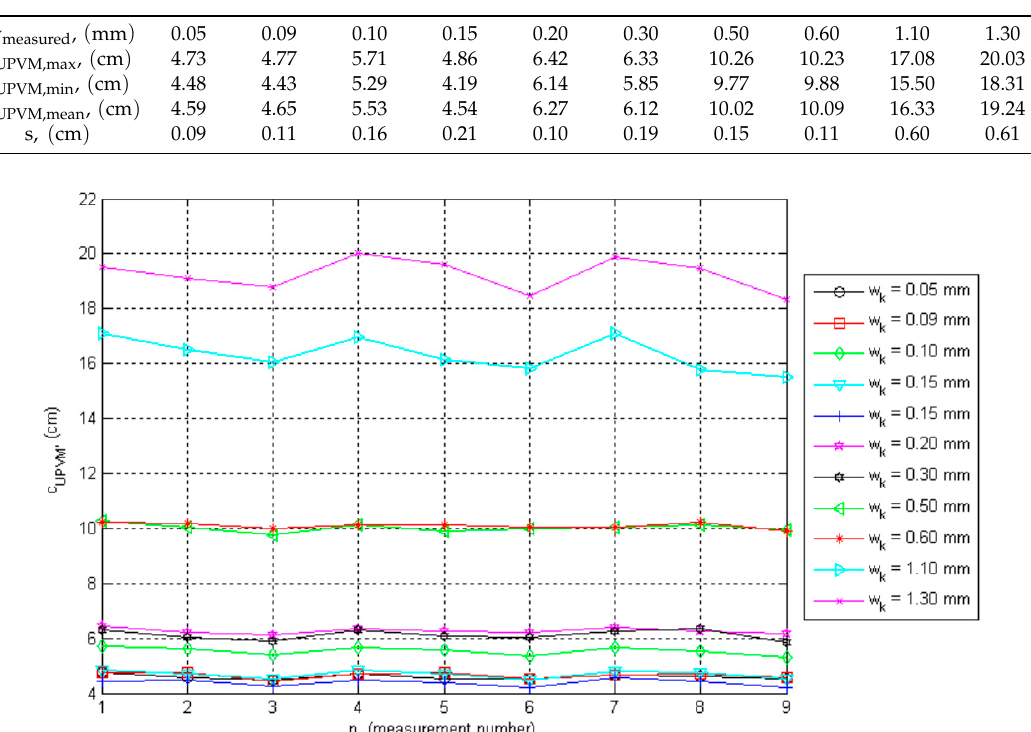
Table 2. Maximum, minimum and mean value of depths of cracks determined by non-destructive ultrasonic pulse velocity method (NDUPVM), c UPVM and standard deviation for the corresponding crack widths.